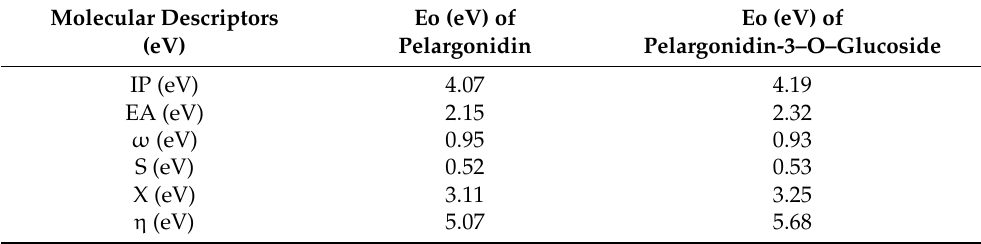
Table 1. Molecular descriptive parameter values of pelargonidin and